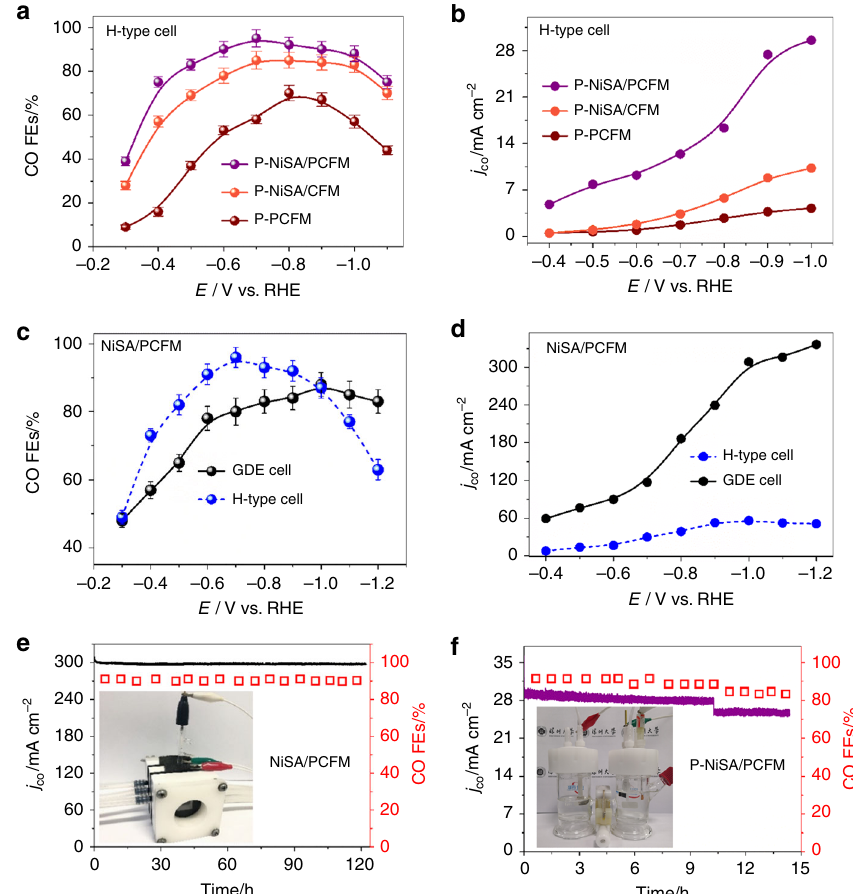
Fig. 4 Electrocatalytic CO 2 reduction. a CO faradaic ef fi ciency and b partial current densities for three catalysts at various cathode potentials in H-type cell. c CO faradaic ef fi ciencies, d partial current densities of NiSA/PCFM at various cathode potentials in different cells. e Long-term stability tests in GDE cell and f H-type cell at – 1.0 V RHE ,